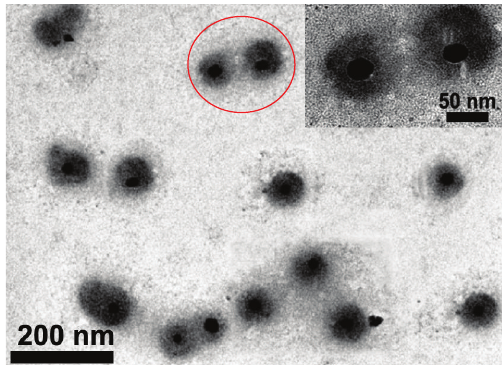
Figure 7: High-resolution TEM micrograph of the hybrid nanopar- ticles. Inset is the magnified image of the region in red circle. Note. Staining was performed with phosphotungstic acid